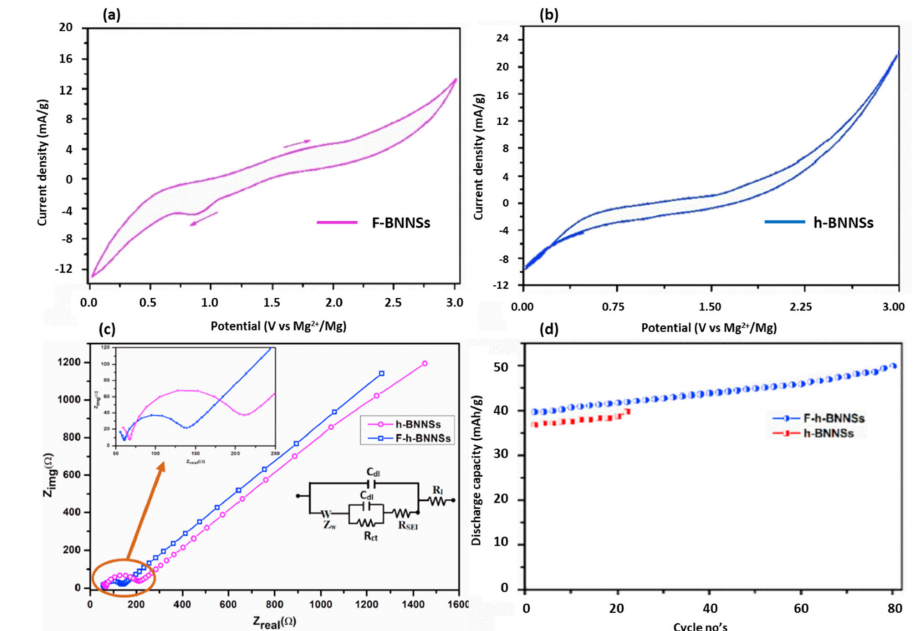
Figure 3. CV plots at a scan rate of 5 mVs − 1 in the voltage range of 0.0–3.0 V ( a ) F doped 2D h-BN and ( b ) undoped 2D h-BN cathodes ( c ) Impedance spectrum of doped and undoped 2D h-BN cathodes, ( d ) Cycle life of doped and undoped BN cathodes [83] (Reprinted with permission from Elsevier B.V, Copyright ©